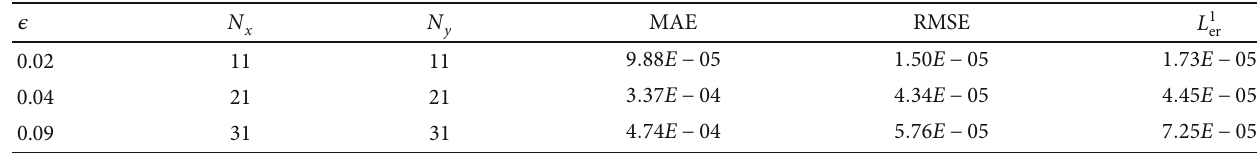
, N , and ϵ using MQ. x y